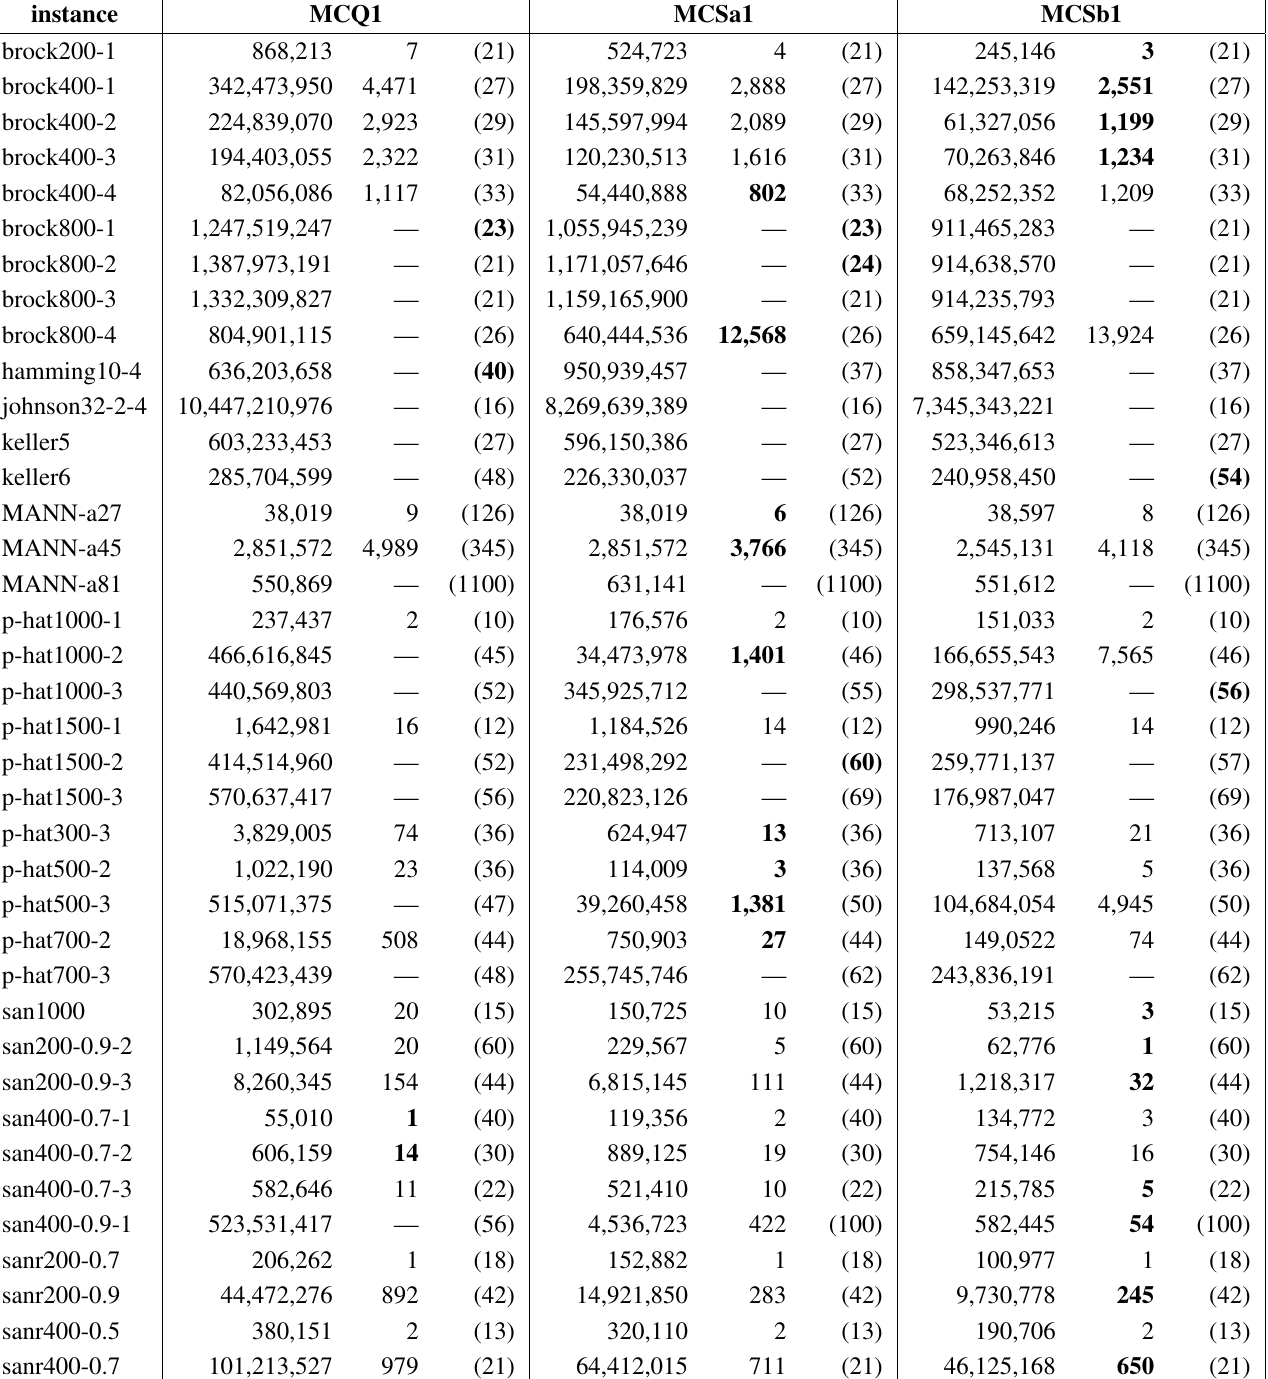
Table 1. DIMACS instances: MCQ vs. MCS, nodes, run time in seconds and (clique